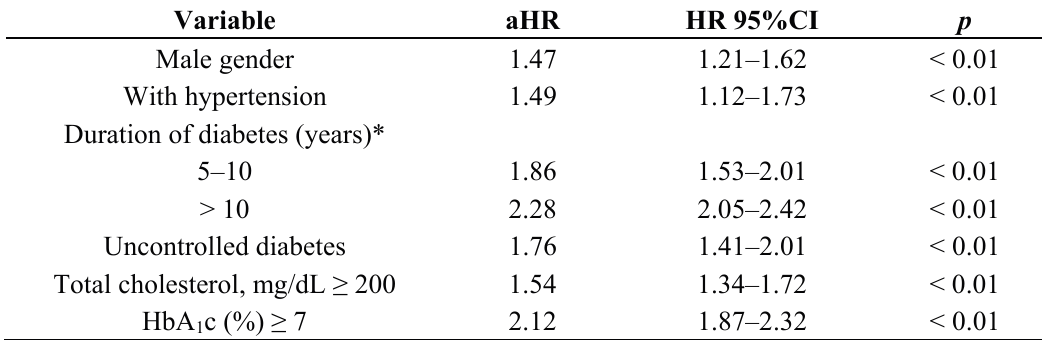
Table 4. Adjusted hazard ratios of the factors associated with onset of